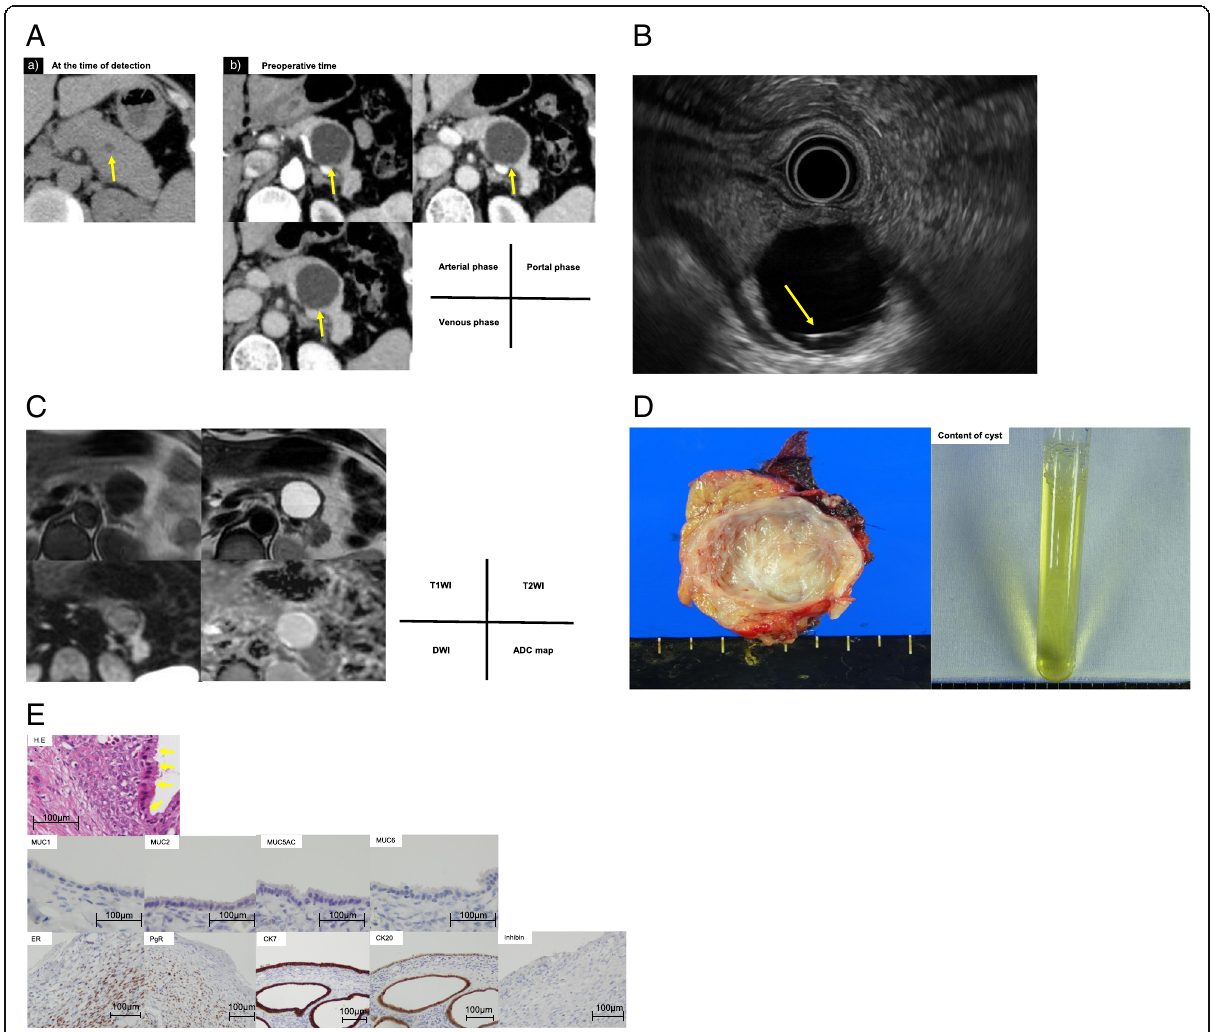
Fig. 2 a Abdominal CT at the time of detection (a) and preoperative CT (b) revealed low-density cystic tumor in the tail of the pancreas in all phases (arrow), but no septum or nodules were detected in the cyst. b Endoscopic ultrasound showed a cystic tumor with a septum (arrow). c Magnetic resonance imaging showed a low-intensity T1 signal and high-intensity T2 signal in the tumor. d The resected cyst specimen contained serous and yellow fluid. e Microscopic examination showed that the tumor was a unilocular cyst and had a thin septum. The epithelial cells were lined with a single layer of cuboidal pancreato-biliary cells (arrow) and had no sign of malignancy. The cellular ovarian stroma was present beneath the epithelium with hematoxylin and eosin staining. Immuno-pathologically, the tumor showed nuclear expression of an estrogen receptor and a progesterone receptor in the stromal cells, and the epithelial cells showed no expression of MUC1, 2, 5AC, and 6, which showed that the tumor had an ovarian-like-stroma but not MUC secretion. CT computed tomography, MUC